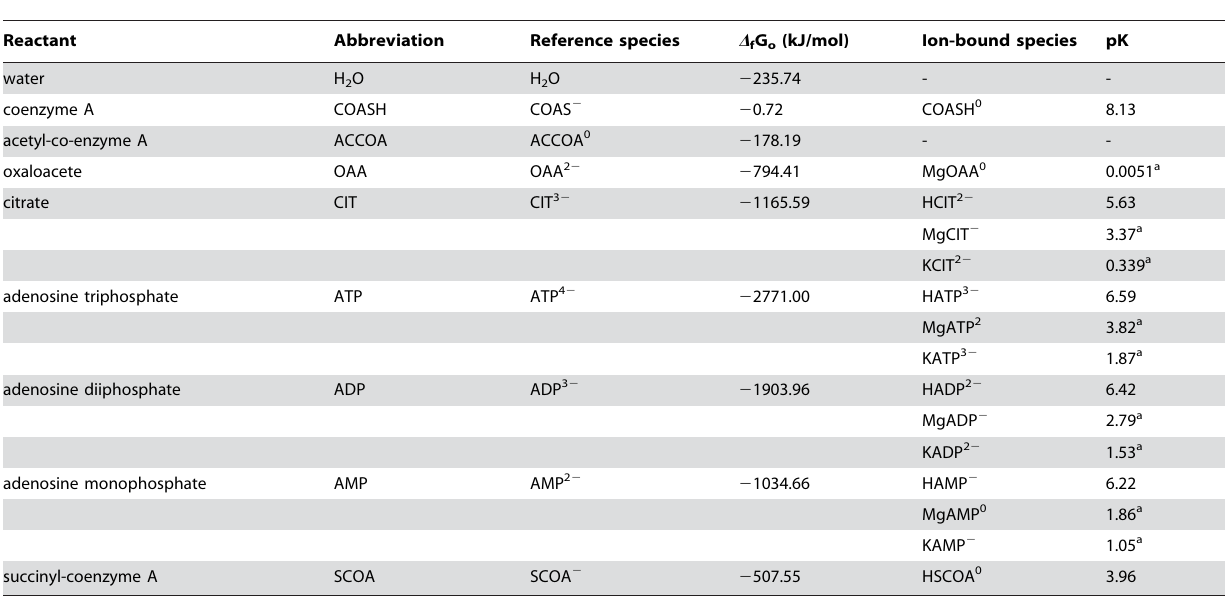
Table 1. Thermodynamic Parameter Values for Citrate Synthase (298.15 K, 1 M reactants, I =0.17 M, P =1 atm).